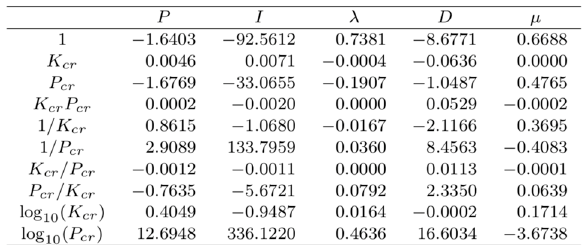
Figure 7. Parameters for the second set of tuning rules for processes with critical gain and period ( P = k p , I = k p /T i , D = k p T d ) [42].